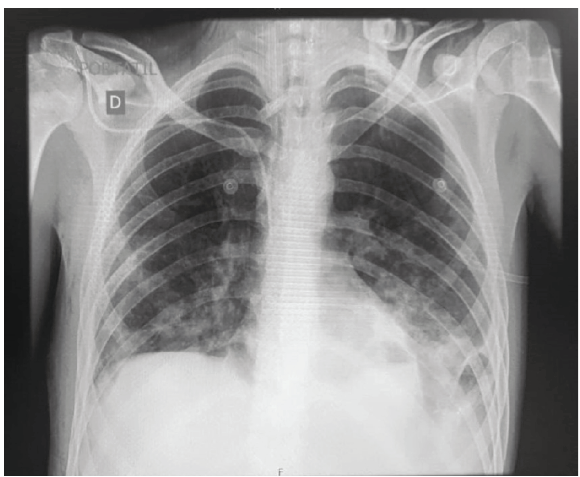
Figure 1: Frontal chest radiograph showing consolidation of both lungs with increasing density towards the lung bases, predominantly the left lung base.